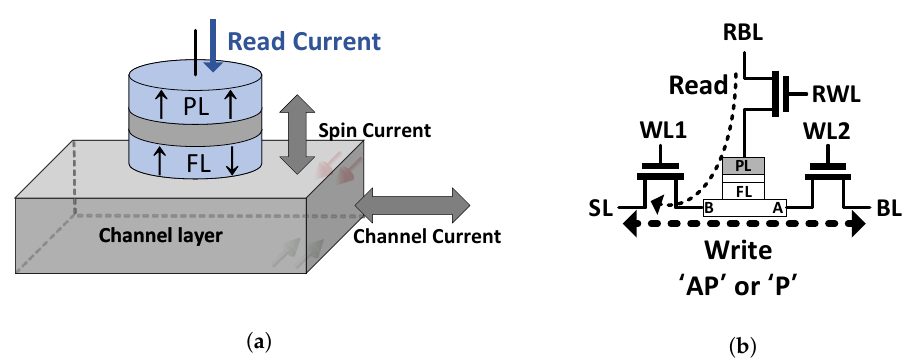
Figure 1. An SOT-MTJ device: ( a ) structure; ( b )